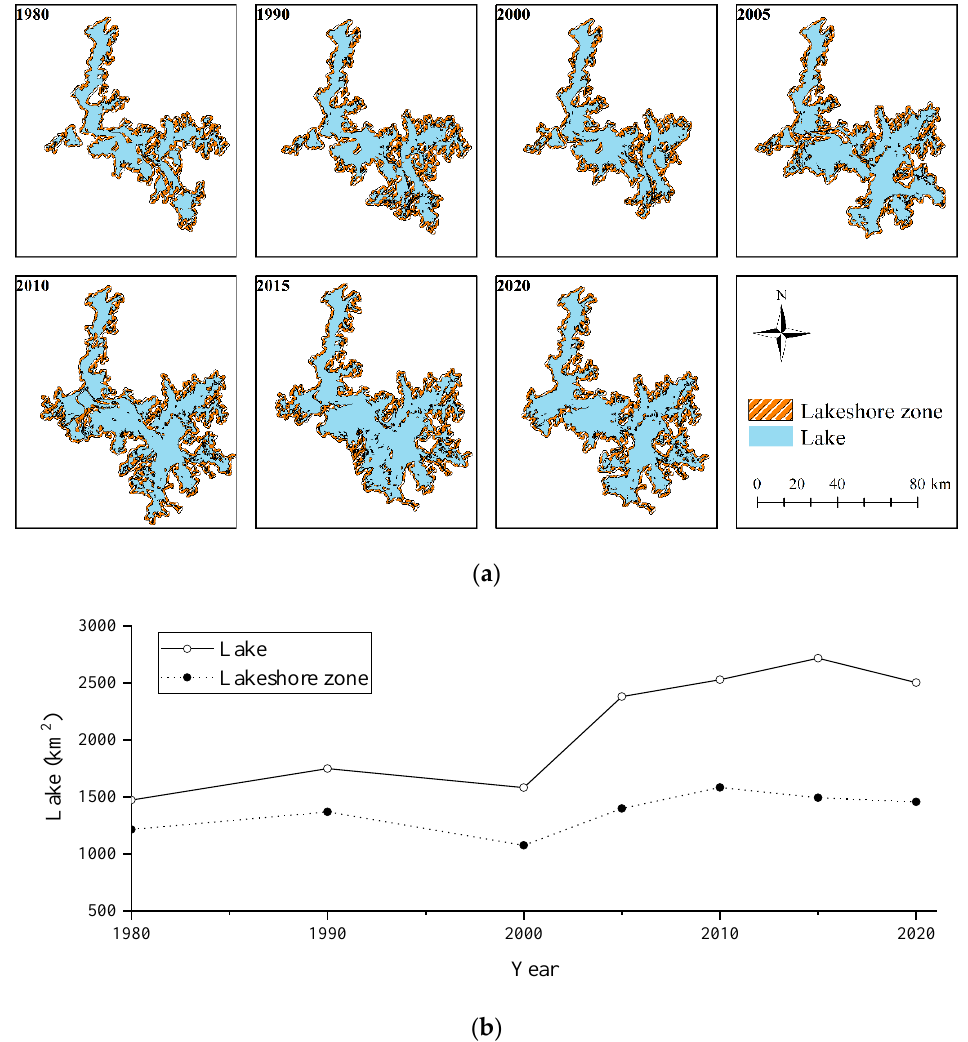
Figure 2. ( a ) Spatial changes and ( b ) area changes of Poyang Lake and the lakeshore zone from 1980 to